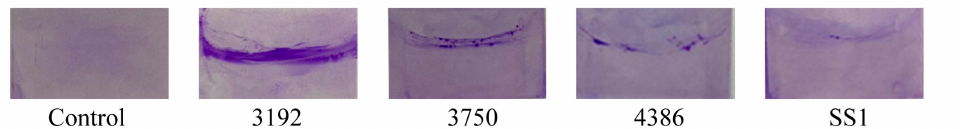
Figure 2. Biofilm formation by four H. pylori strains on glass coverslips after four days in BB2. H. pylori strains: 3192, 3750, 4386, SS1. Biofilm was formed at the gas–liquid interface on 20 mm × 20 mm borosilicate coverslips and stained with 1% crystal violet